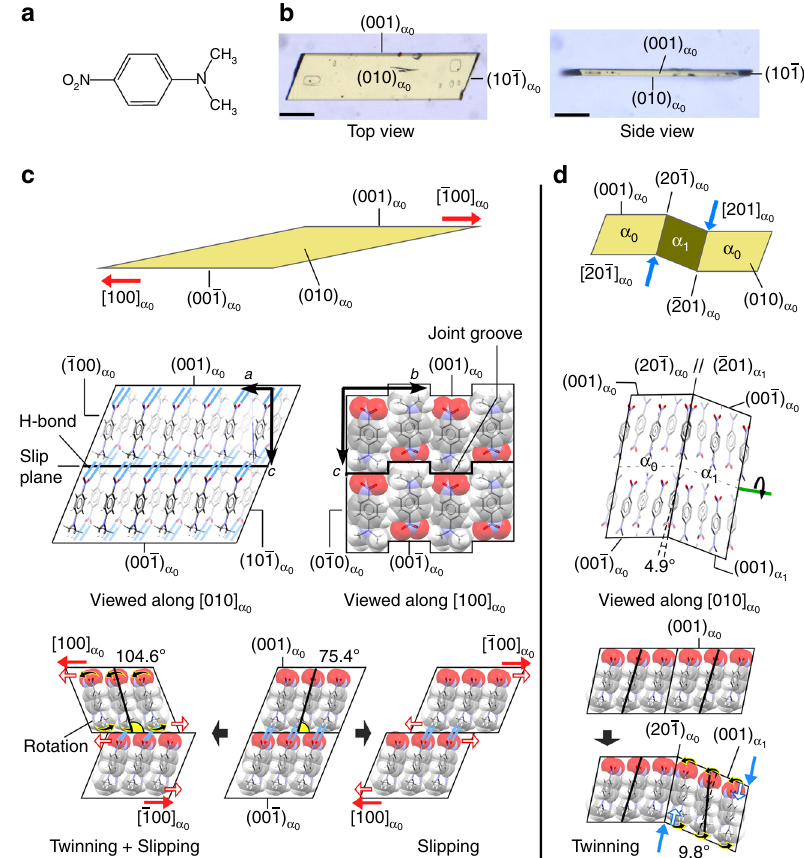
Fig. 1 Two types of plastic deformation in crystals of 1 . a Molecular structure of 1 . b Crystal photos of 1 with face indices before deformation. Scale bar, 100 μ m. c Deformed shape of a crystal of 1 in superplastic deformation, with 500% strain (top), and the micro structures (middle) and slip mechanism showing shearing in the opposite (bottom left) and same (bottom right) directions as the molecular tilting direction in the single crystals. d Bending shape (top), micro structure around an interface between twins (middle), and orientation change (bottom) in superelastic